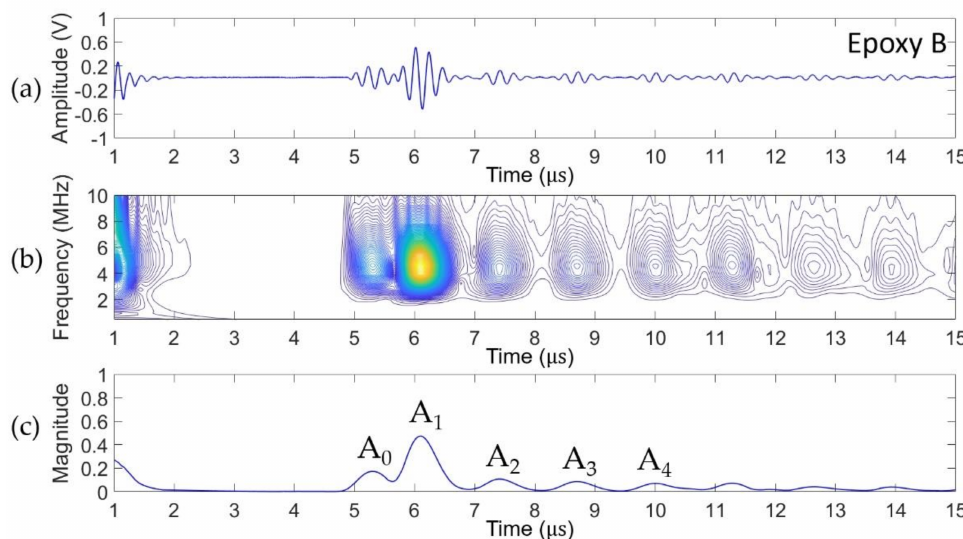
Figure 10. Ultrasonic signal from the pulse-echo experimental result of the perfectly bonded section of epoxy B: ( a ) time-domain waveform, ( b ) time-frequency representation, and ( c ) the projection of the STFT.